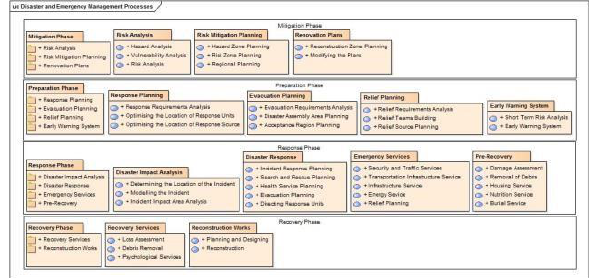
Figure 3: Disaster and emergency management processes